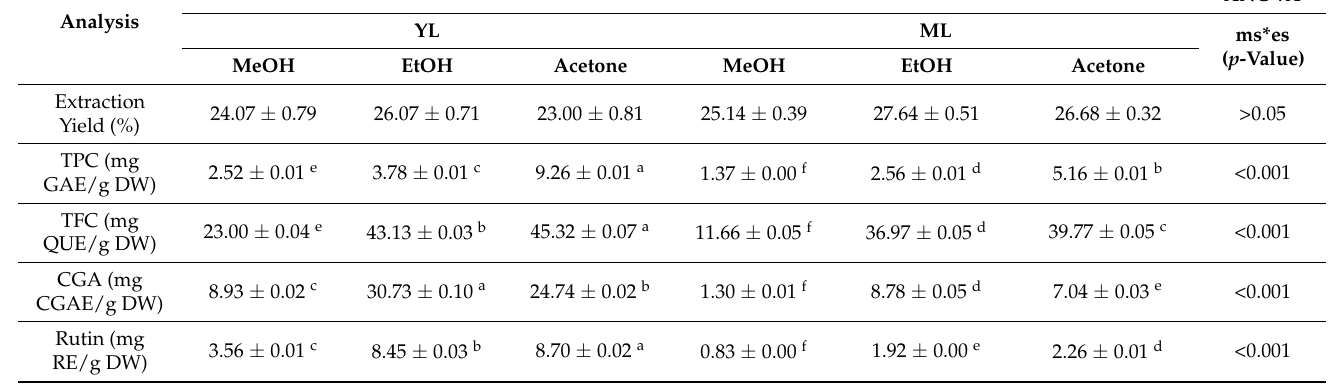
Table 2. The values of extraction yield, total bioactive content, chlorogenic acid, and rutin of mulberry leaves. The result of two-way ANOVA is shown for the interaction of the two factors: maturation stages (ms) and extraction solvent